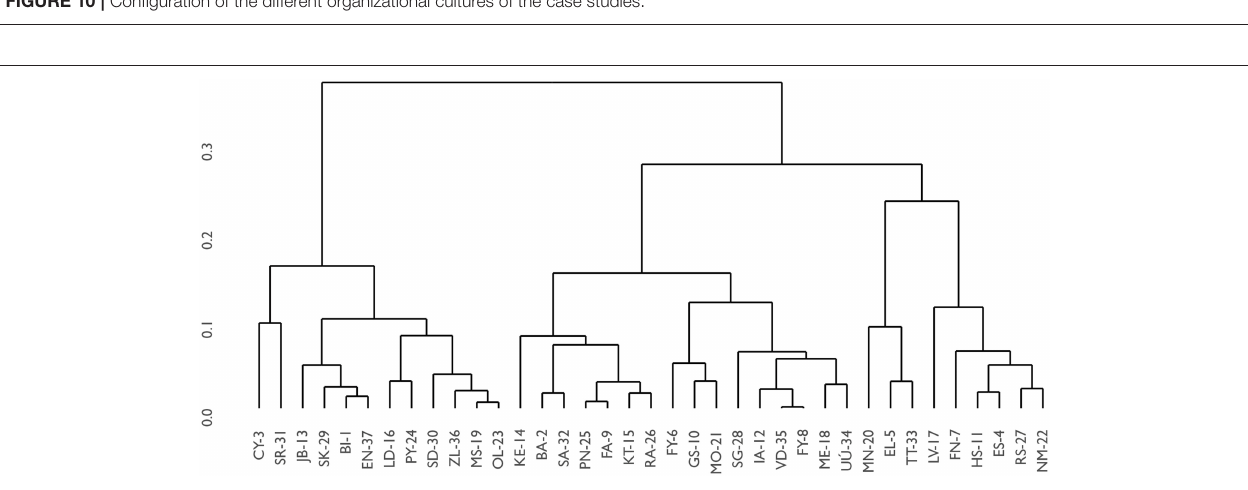
FIGURE 10 | Configuration of the different organizational cultures of the case studies.